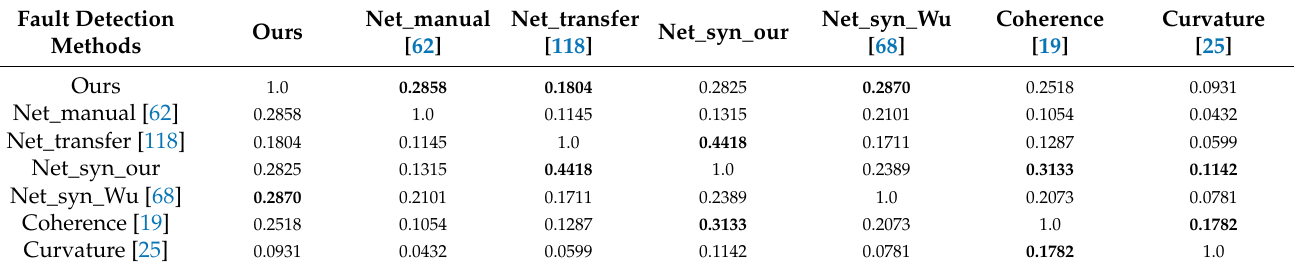
Table 1. Results Comparison Test with F1 Score in Work Area A.